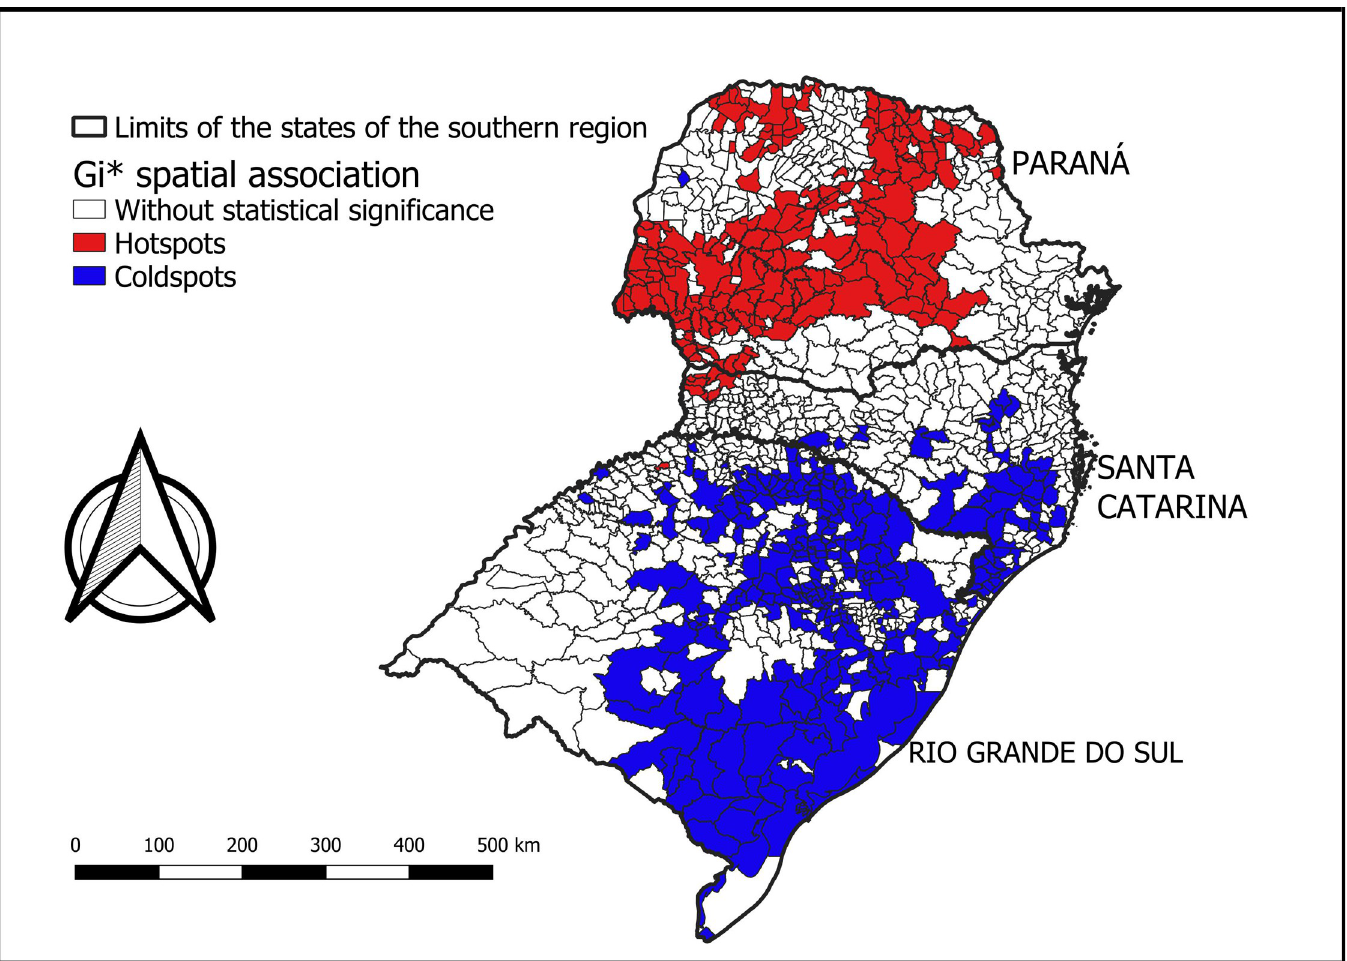
Fig 2. Areas of spatial association according to the Gi � technique, showing hotspots and coldspots for the incidence of leprosy in southern Brazil, in the period 2010 to 2016.